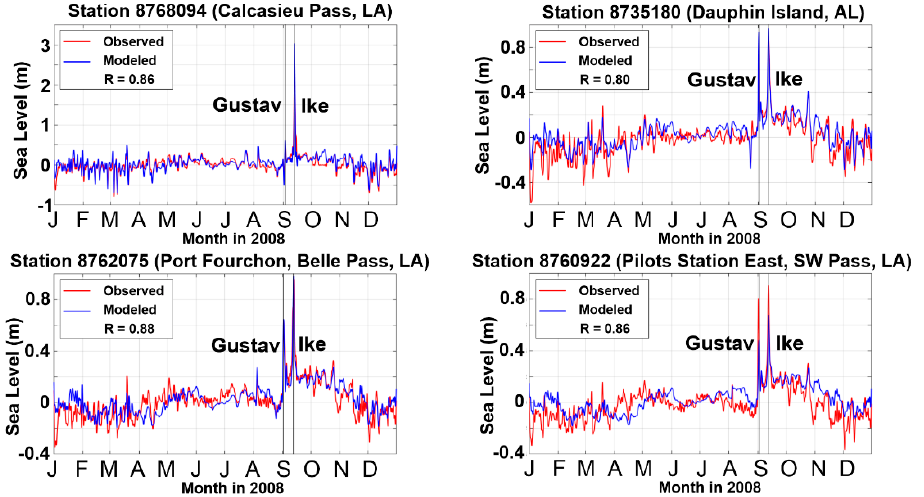
Figure 4. Comparison of model simulated and observed sea-level anomaly time series in 2008. Two peaks in September are storm surges introduced by hurricane Gustav and Ike.